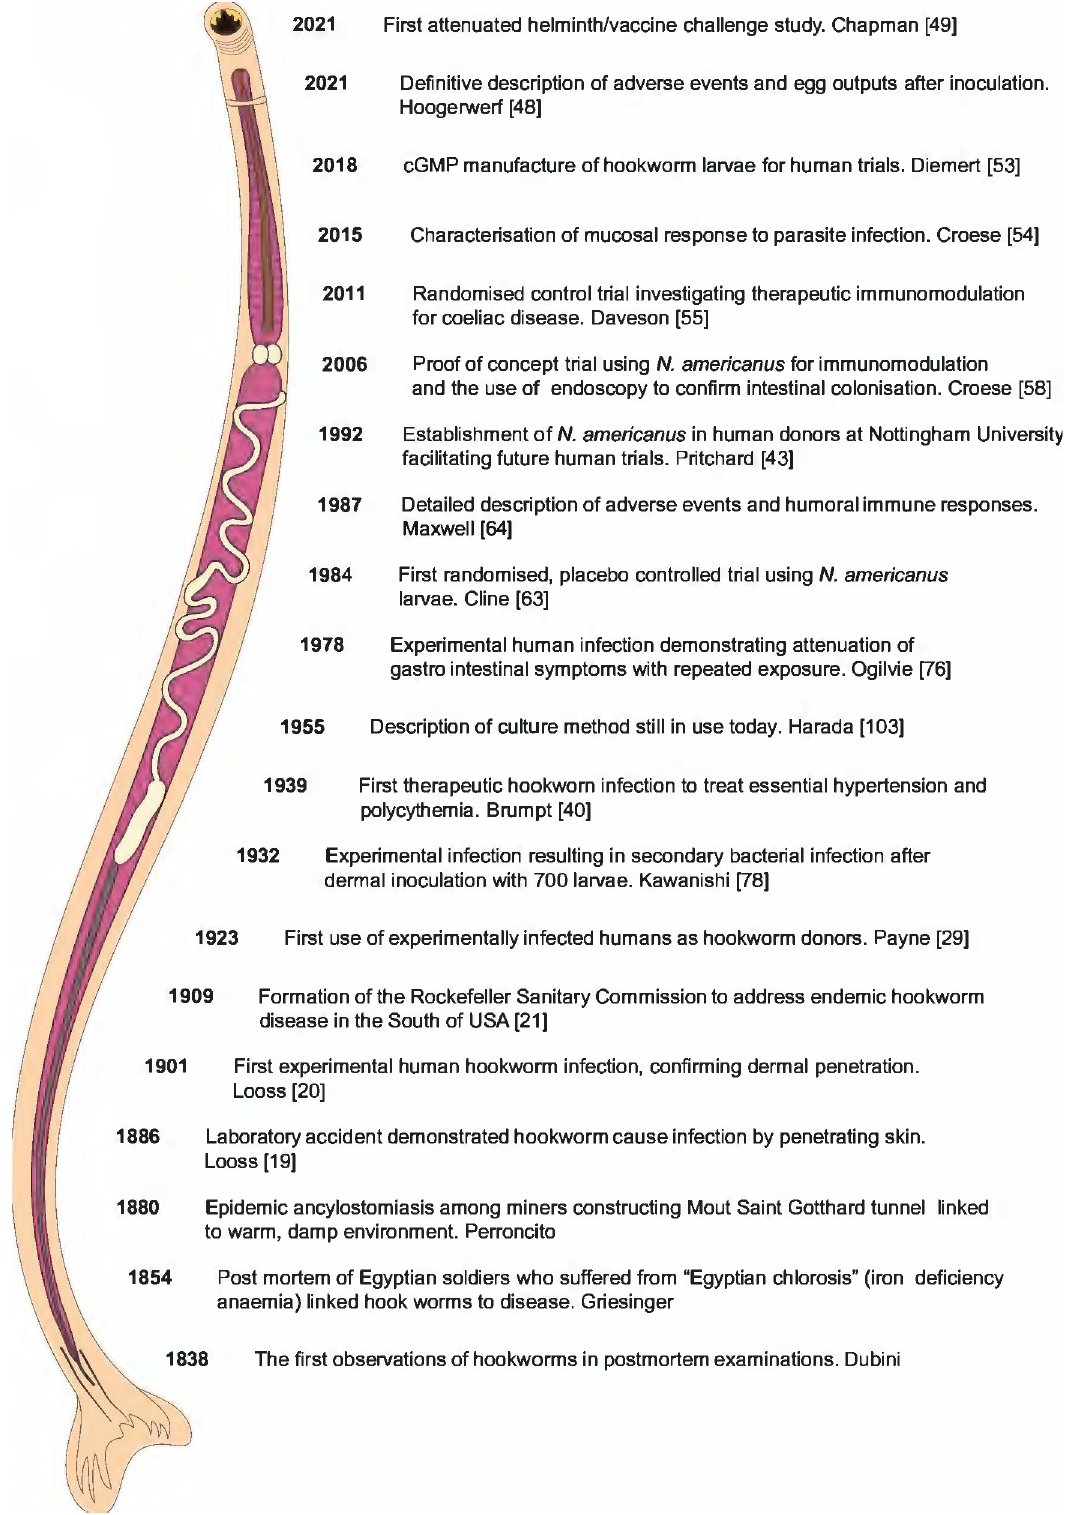
Fig 1. Significant events in experimental human hookworm infection. Historical aspects of human hookworm infection.